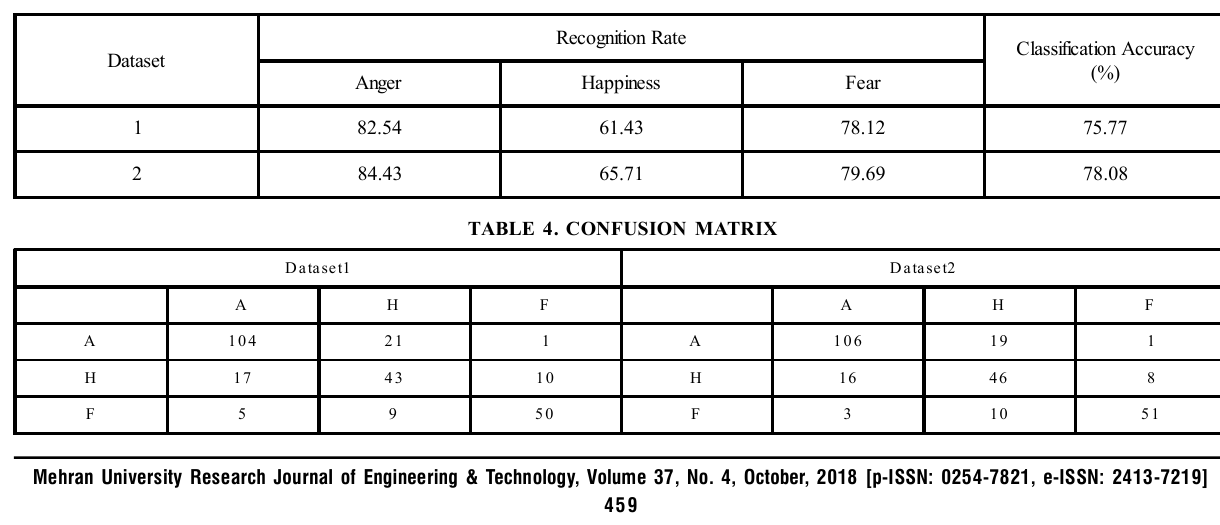
TABLE 3. THE RECOGNITION RATE AND CLASSIFICATION ACCURACY FOR DATASET1 AND DATASET2